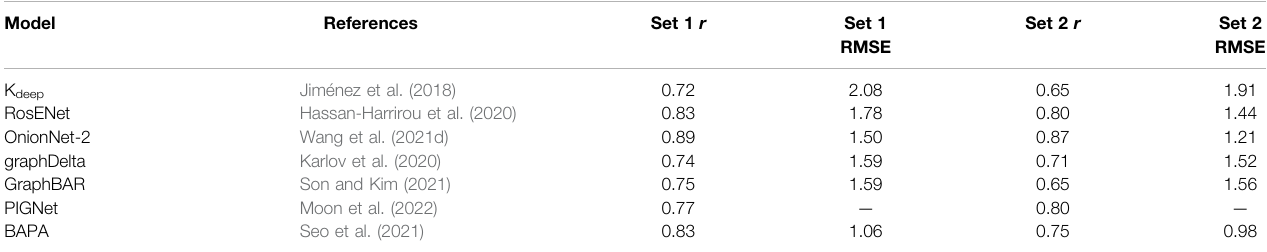
TABLE 3 | Performance of the models summarized in Table 2 on the CSAR-NRC HiQ scoring benchmark. We only report evaluation results from the original reference. RMSEs are expressed in pK